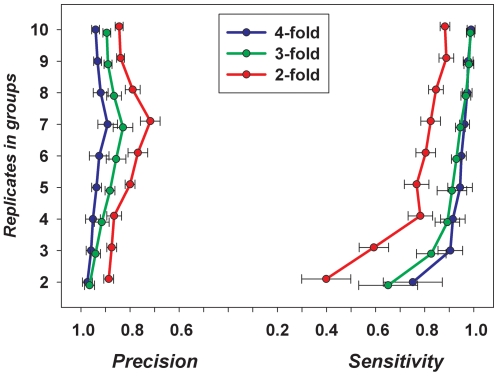
The influence of the number of replicates (Power analysis).Dependence of the quality of Associative analysis (Fa = 1.5, Em = 20) from the number of replicates is shown for different introduced fold changes Fd (X axis - Precision on the left side, and Y axis - Sensitivity on the right side). The results are obtained as an average of the analysis of three bootstrapped datasets and expressed as mean/SD.